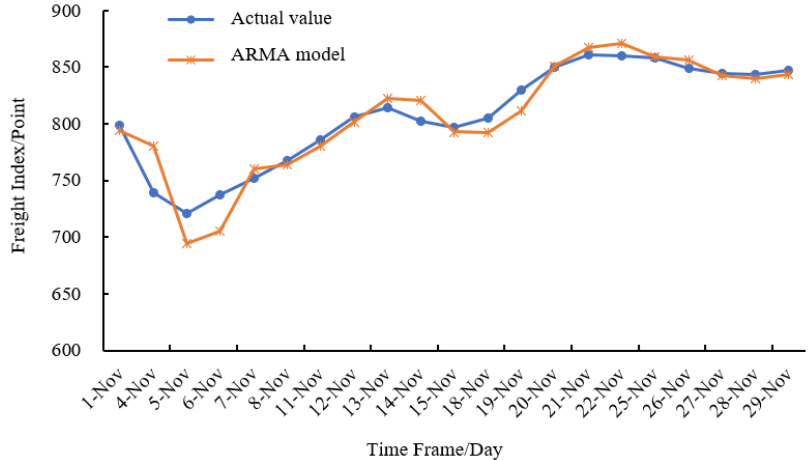
Figure 4. Comparison between forecasting result of ARMA model and real value.